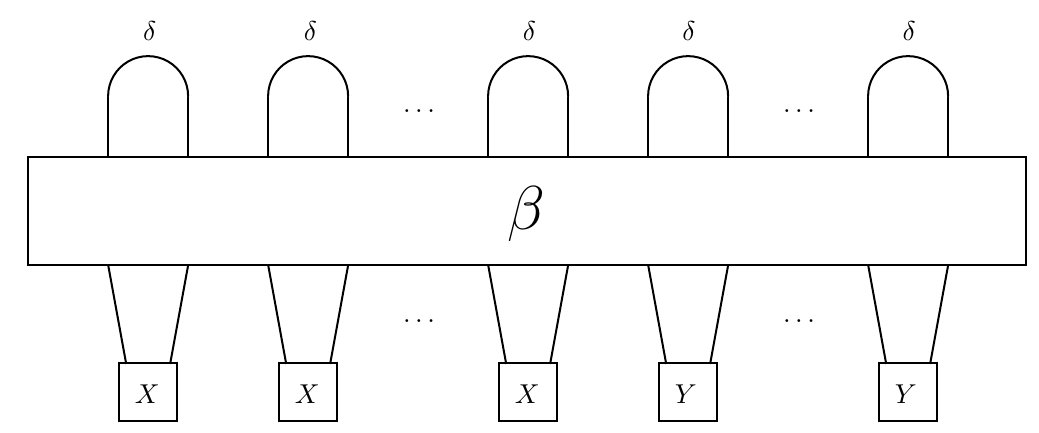
Figure 2 . A diagrammatic representation of the index contraction in a mesonic operator, where each line represents an index. There are n X s and m Y s, and (cid:12) 2 C ( S 2 n +2 m